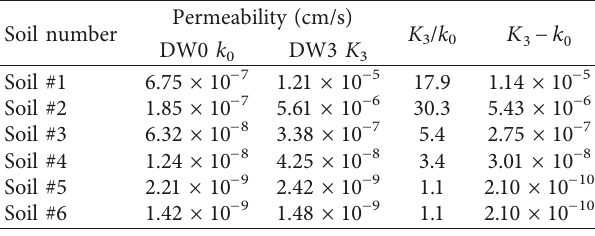
Table 5: Permeability test results of the six CCLs.